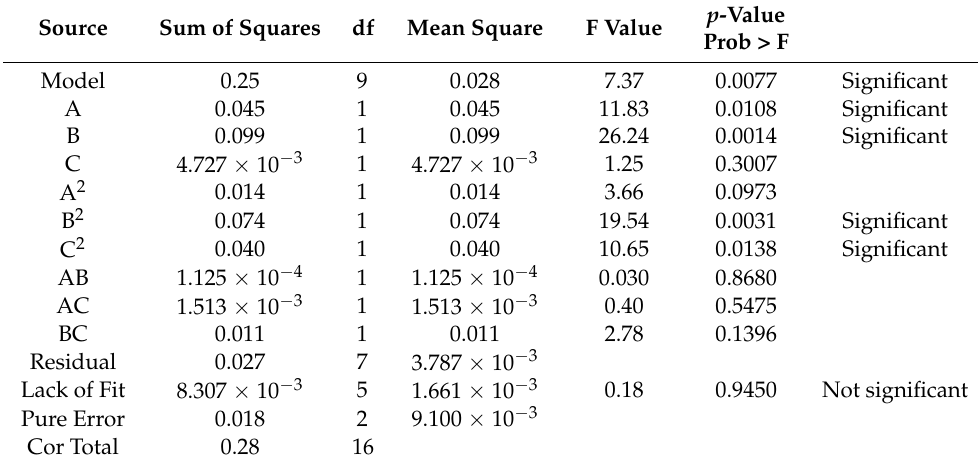
Table 2. ANOVA for the experimental results of the central composite design belonging to biomass